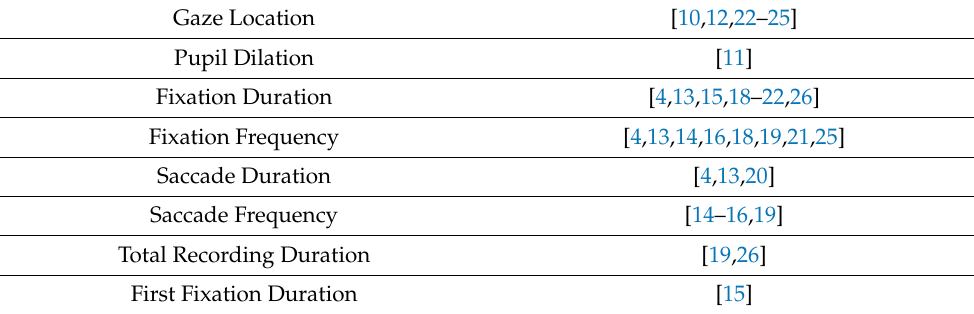
Table 1. Standard metrics used for evaluating visual